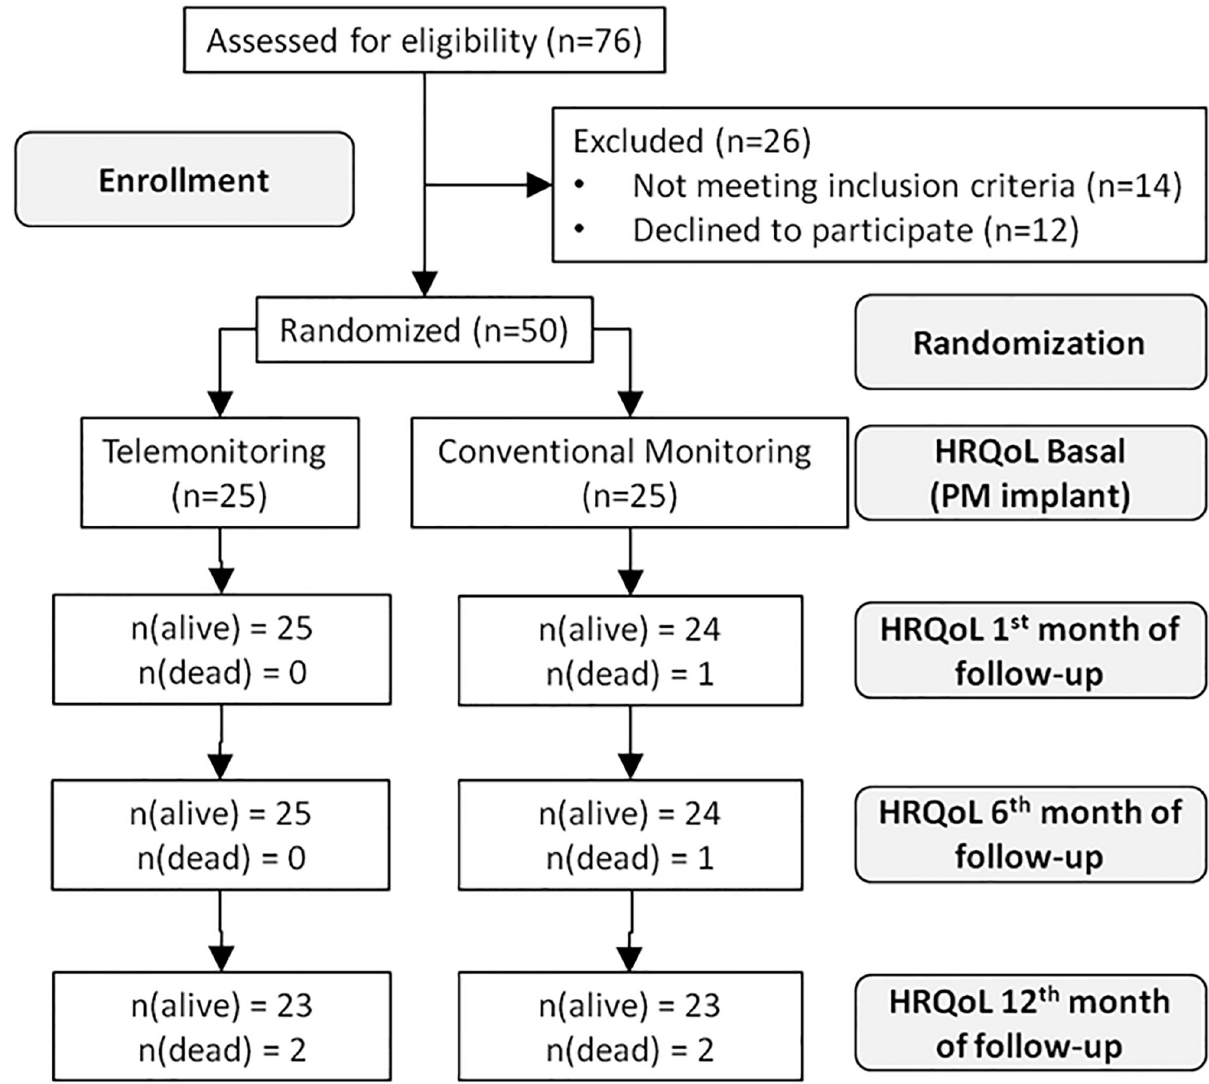
Fig 1. Flow diagram (CONSORT) of the